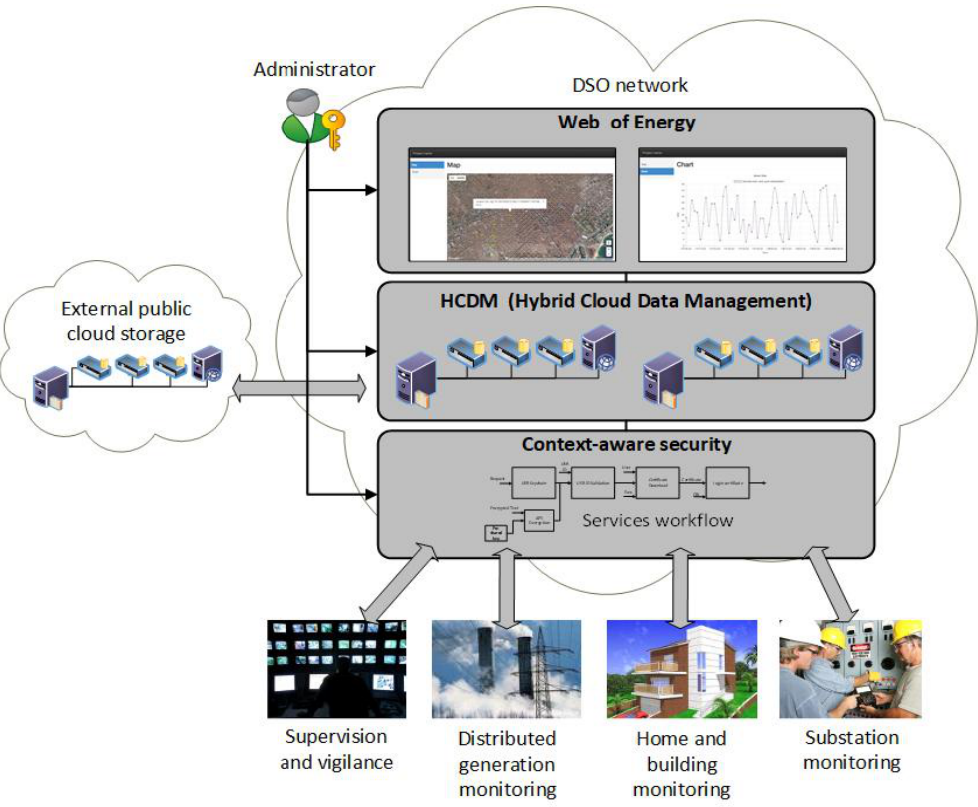
Figure 1. Main software-defined utility modules: context-aware security, Hybrid Cloud Data Management (HCDM) system, web of energy.